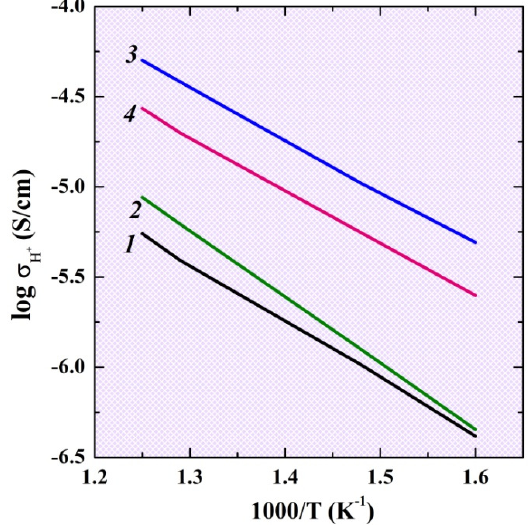
Figure 7. The temperature dependencies of protonic conductivity for the investigated compositions BaLa 2 In 2 O 7 (1), BaLa 1.9 Ca 0.1 In 2 O 6.95 (2), BaLa 1.9 Sr 0.1 In 2 O 6.95 (3), BaLa 1.9 Ba 0.1 In 2 O 6.95 (4).